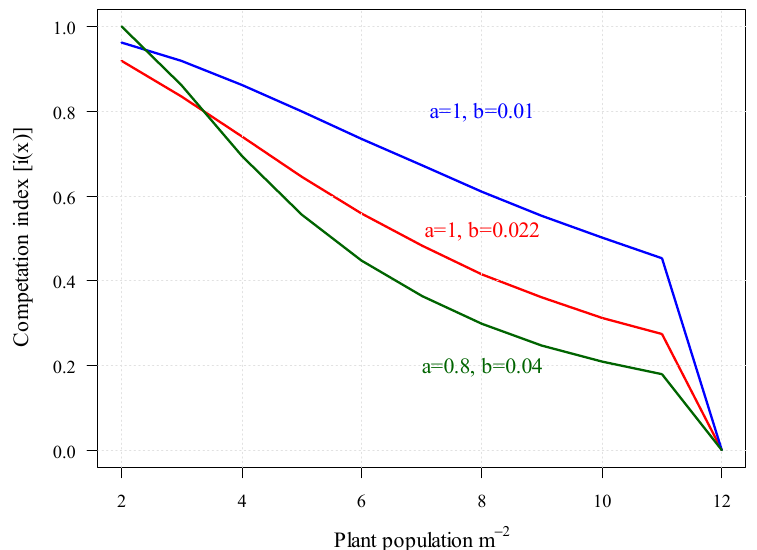
Figure 8. Examples of the simulation function indicated with different curve colors (a and b are constants in Equation (9)).